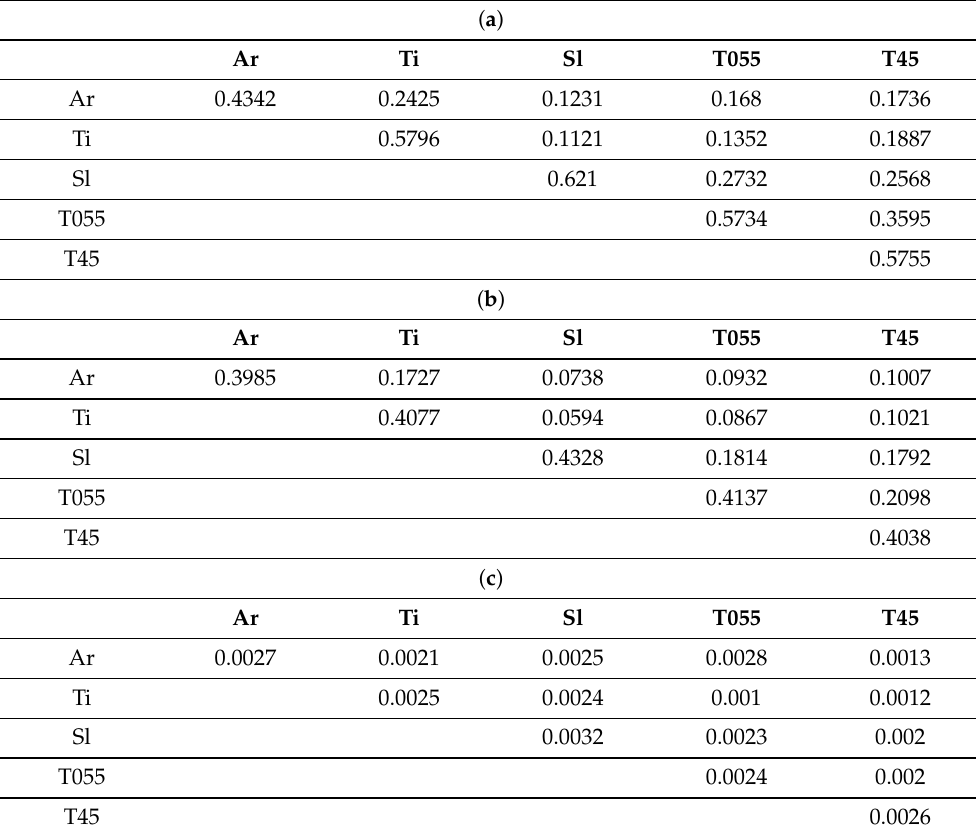
Table 4. SSIM indices of SAR versus scan images of five ships, ( a ) noise free, ( b ) mean value at SNR = − 10 dB, and ( c ) standard deviation at SNR = − 10